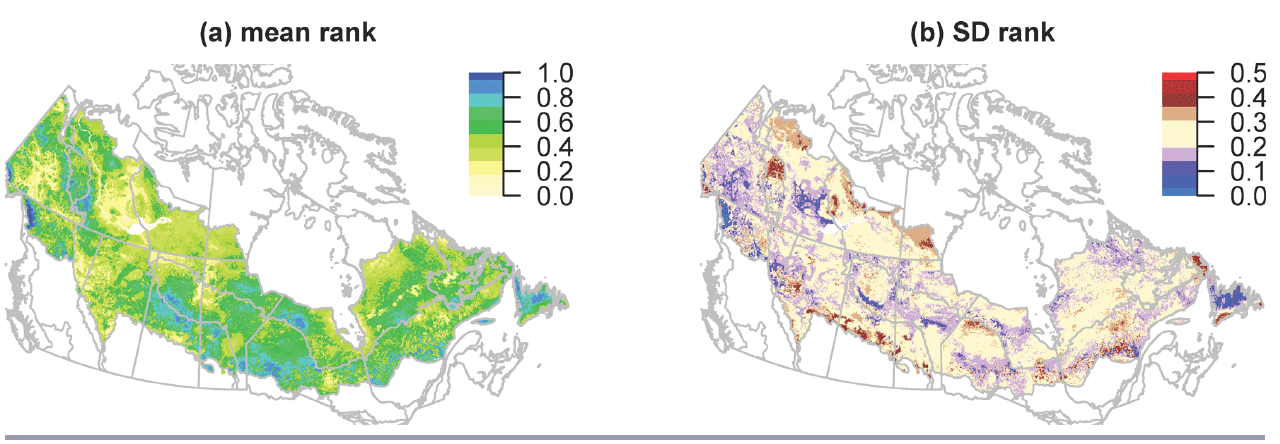
Fig. 4 . (a) Mean Zonation rank, indicating conservation value, across all 128 scenarios. Highest ranked areas are in dark blue; lowest ranked areas are in yellow. (b) Standard deviation of Zonation rank, indicating agreement in conservation value across scenarios. Highest variation in Zonation ranks is in red; lowest variation is in